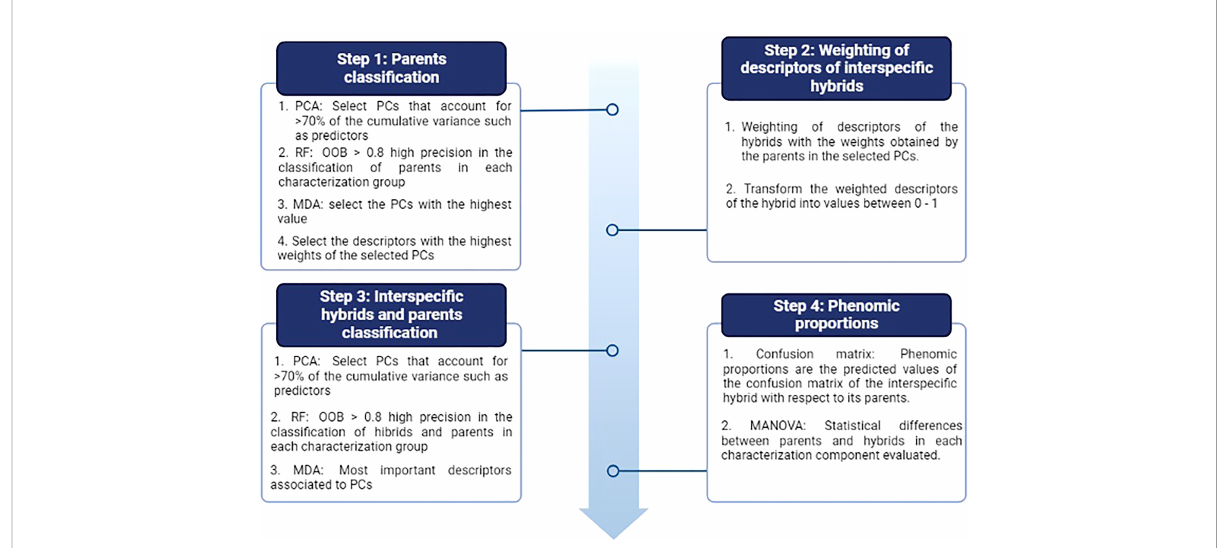
FIGURE 3 Procedure for the analysis of the phenomic proportions between interspeci fi c hybrids and their parents. Four stages are observed that contemplate multivariate (PCA) and random forest (RF) analyses. OOB: Out of bag accuracy and MDA: Mean decrease accuracy. The fi gure shows the evaluation metrics used during each